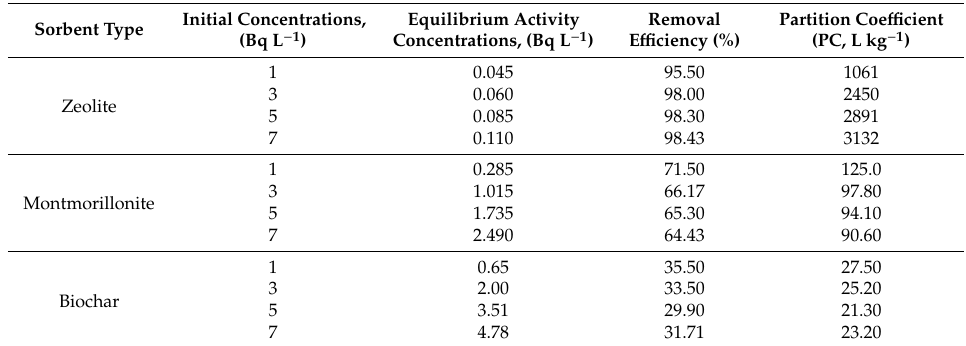
Table 3. Sorbent e ff ects on equilibrium activity concentrations, removal e ffi ciency and partition coe ffi cient of 226 Ra in aqueous